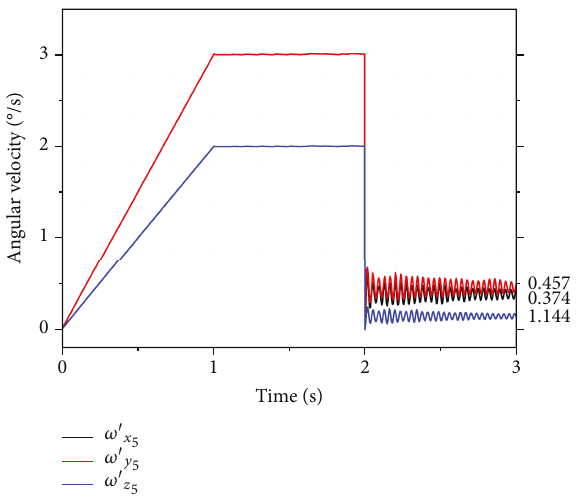
Figure 19: Simulation results of empty storage tank and microsatellite with the deployment mechanism for ω x when ω x ′ = 3 , ω y ′ = 3 , and ω z ′ = 2 .